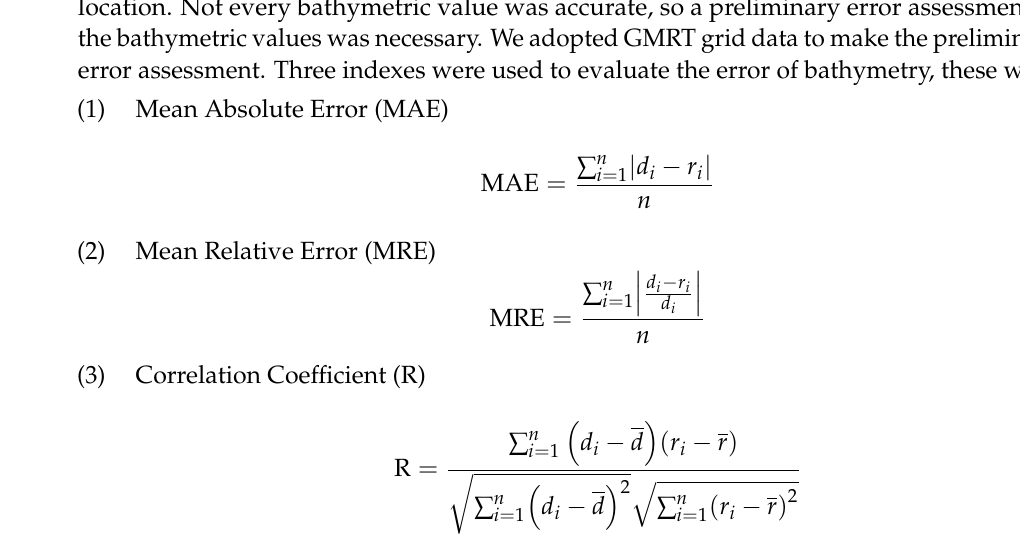
Table 3. The bathymetry error of different images.